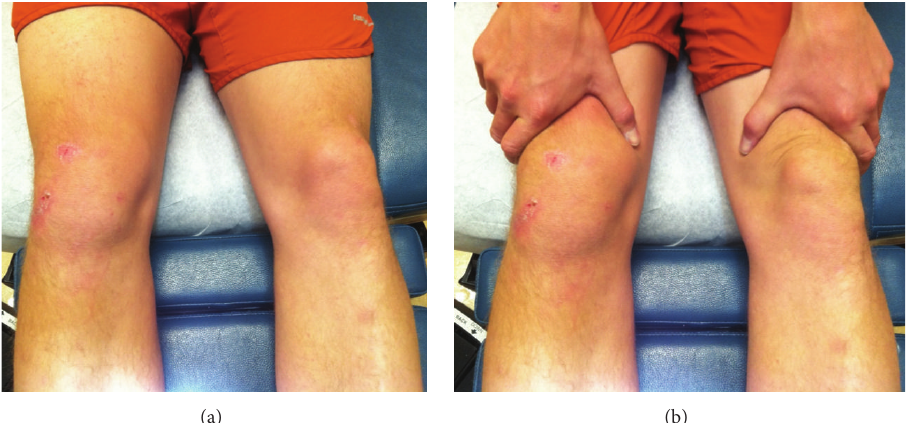
Figure 2: Moderate swelling/effusion in the superomedial aspect of right knee (a) which is accentuated by milking the suprapatellar tissue inferiorly